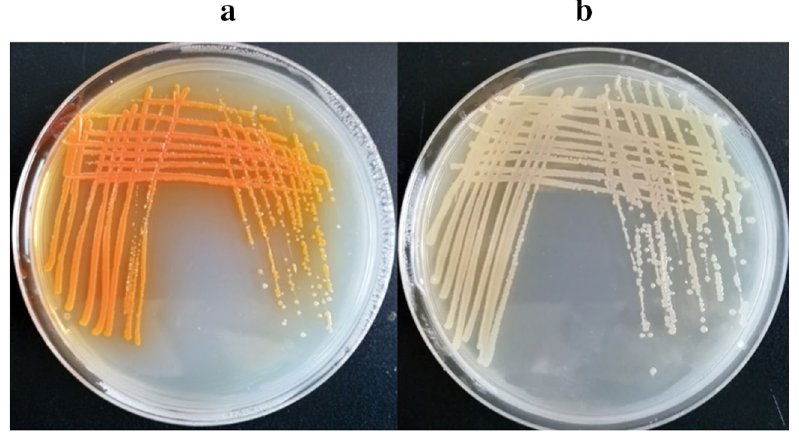
Figure 2. Colony morphology of P. chlororaphis Lzh-T5 and LDA-1. ( a ) Colony morphology of P. chlororaphis Lzh-T5. ( b ) Colony morphology of P. chlororaphis